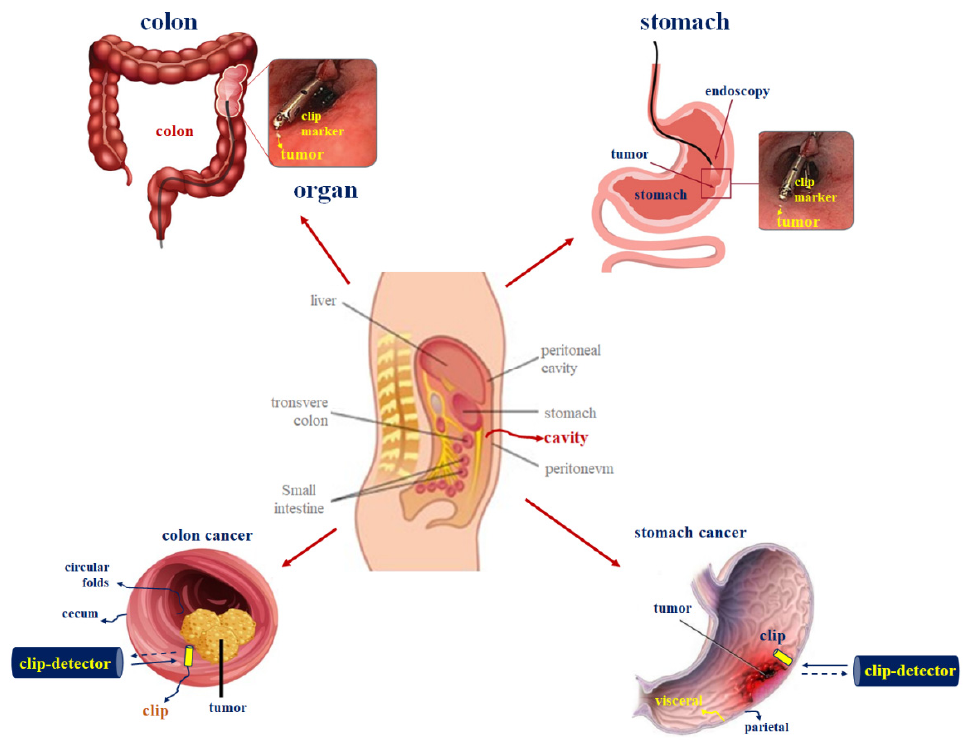
Figure 1. Schematic of the use of clip-detector.